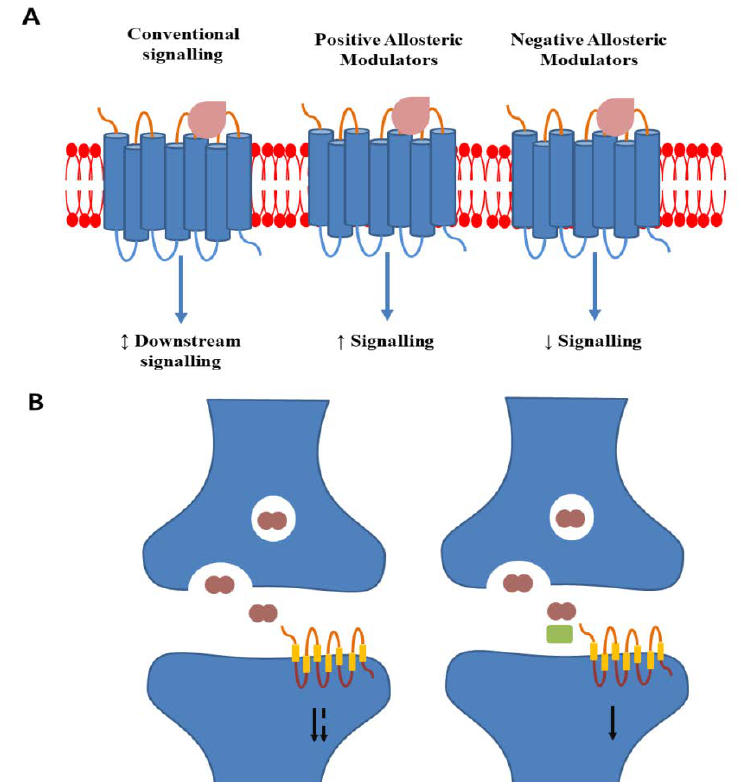
Figure 2. Schematic display of allosteric modulator action on GPCRs. ( A ) Conventional agonist binding makes conformational changes and activates downstream signalling. Positive allosteric modulators bind to a distinct site and enhance conventional ligand-induced signalling. Negative allosteric modulators binding decreases conventional agonist e ffi cacy and reduces downstream signalling. ( B ) In normal physiology, neurotransmitters are released into the synaptic cleft, binding to postsynaptic GPCRs, and activating downstream signalling. The duration of signalling can be degraded by metabolizing enzymes. A positive allosteric modulator (green rectangle) cobinding with the metabolites can extend the duration of receptor activation and enhance signalling (based on